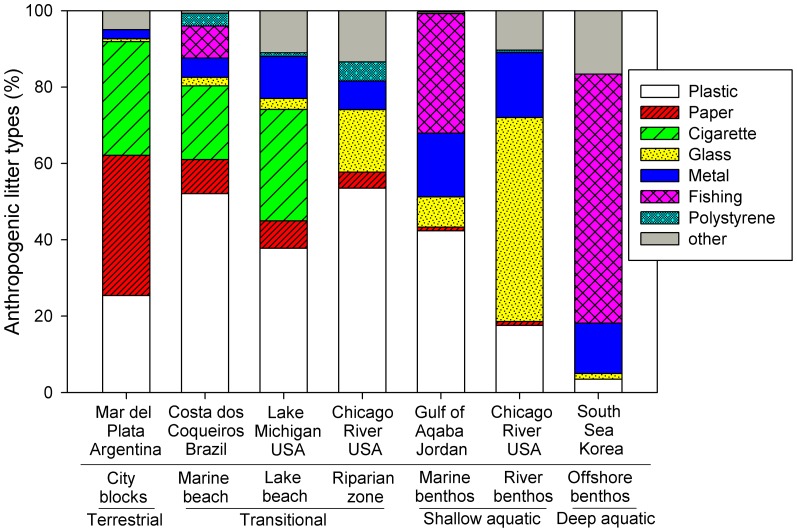
The relative proportion of anthropogenic litter (AL) from our study in the Chicago area (in bold; developed lake beach, riparian zone, and river benthos) relative to city blocks in Argentina [27], a developed marine beach in Brazil [23], a shallow marine benthos site in the Red Sea [1] and an offshore marine benthos site in the South Sea of Korea [29].